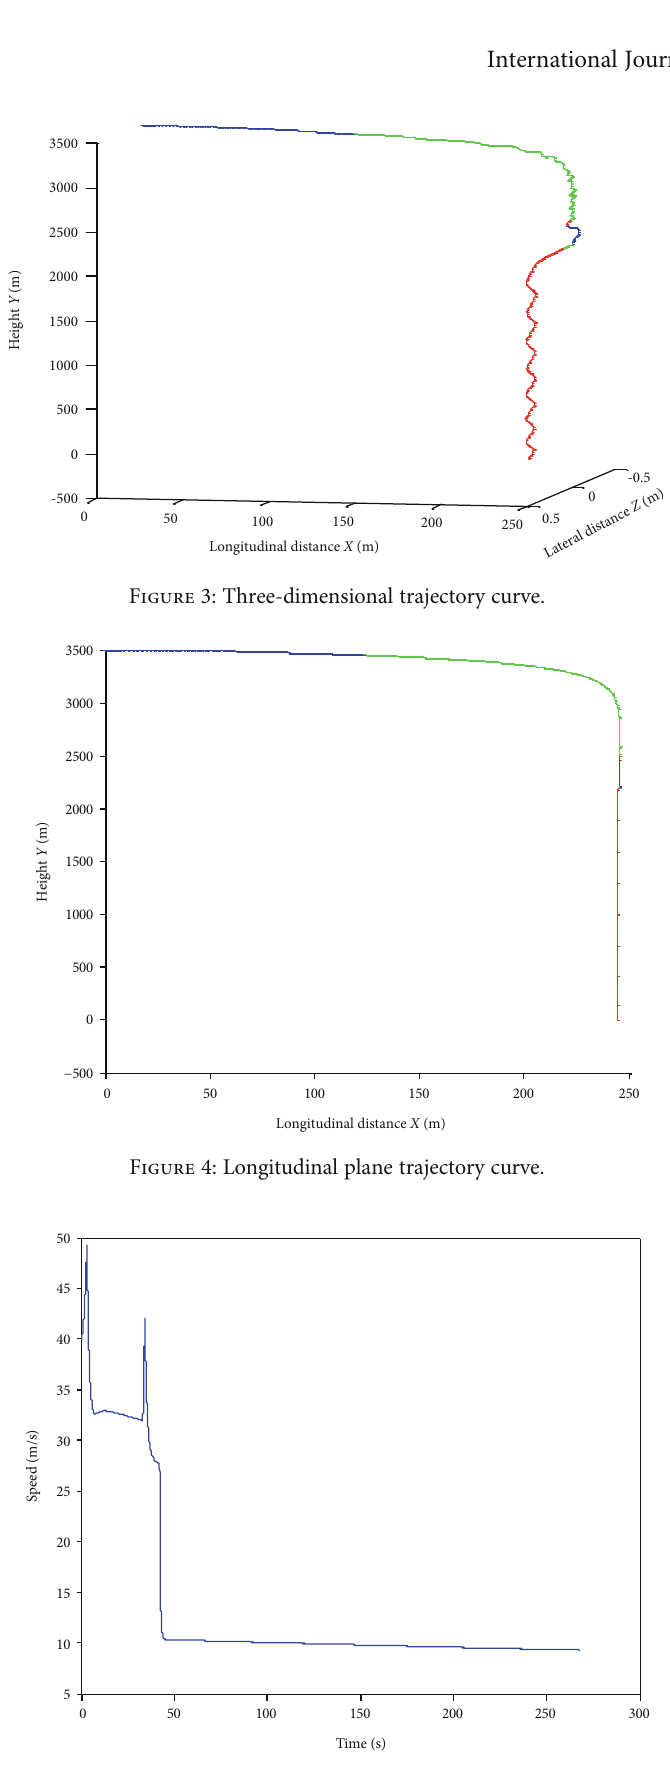
Figure 5: Speed-time